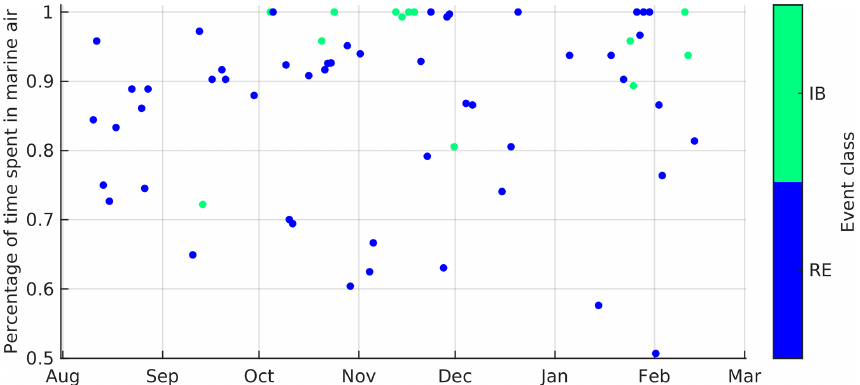
Figure B3. Percentage of time that back trajectories have spent in marine air during events coloured by the event class, where RE stands for regional events and IB for ion bursts.